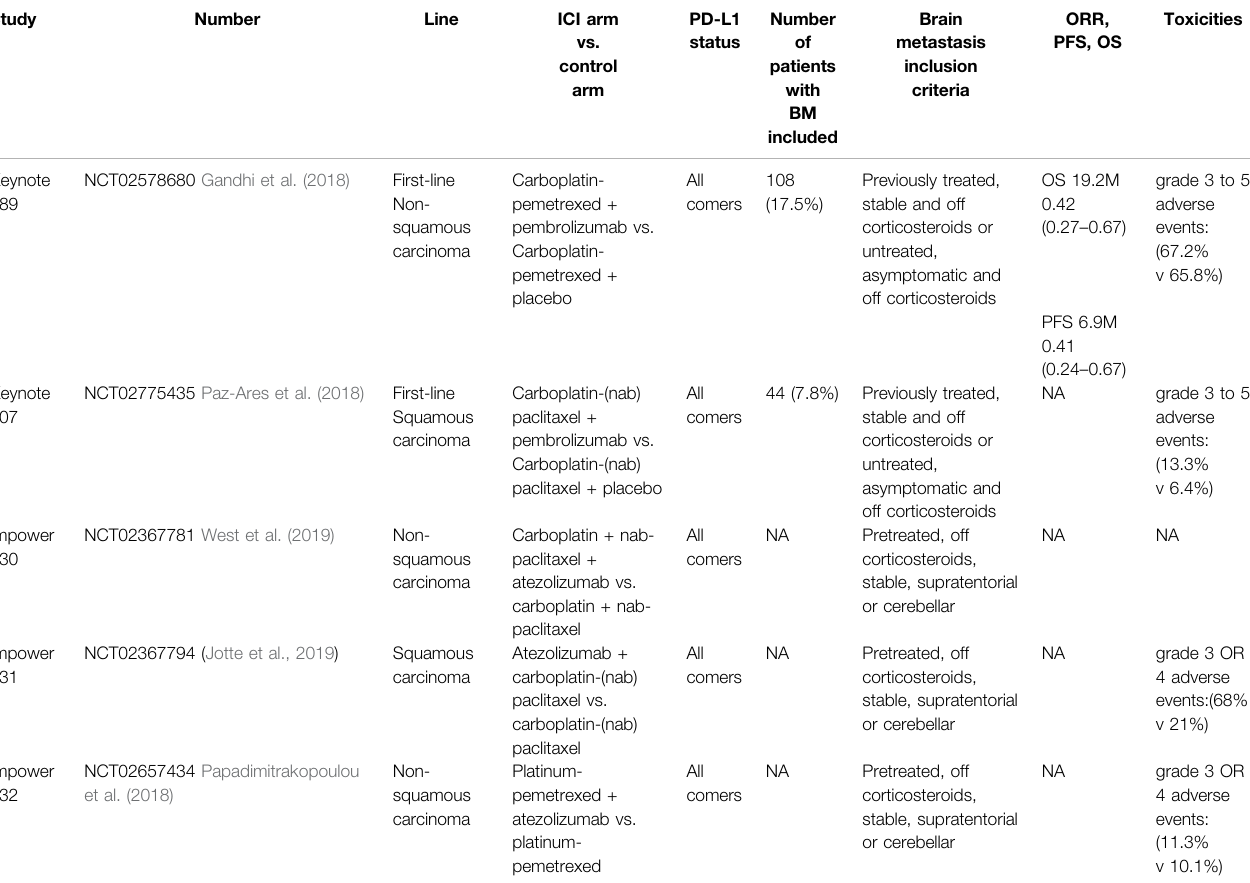
TABLE 2 | Clinical investigations of ICI combined with chemotherapy in the treatment of NSCLC patients with brain metastases.